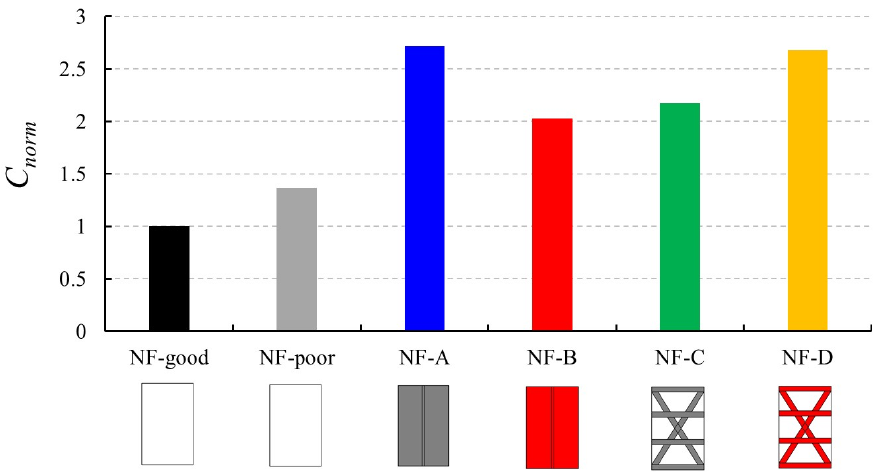
Figure 13. Comparison of normalized coefficients C norm describing the global stiffness